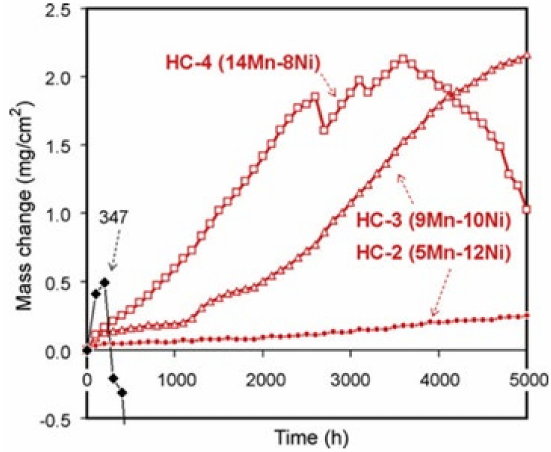
Figure 9. Cyclic oxidation data of 14Cr-2.5Al alloys at 923K in air +10% water vapour [42].